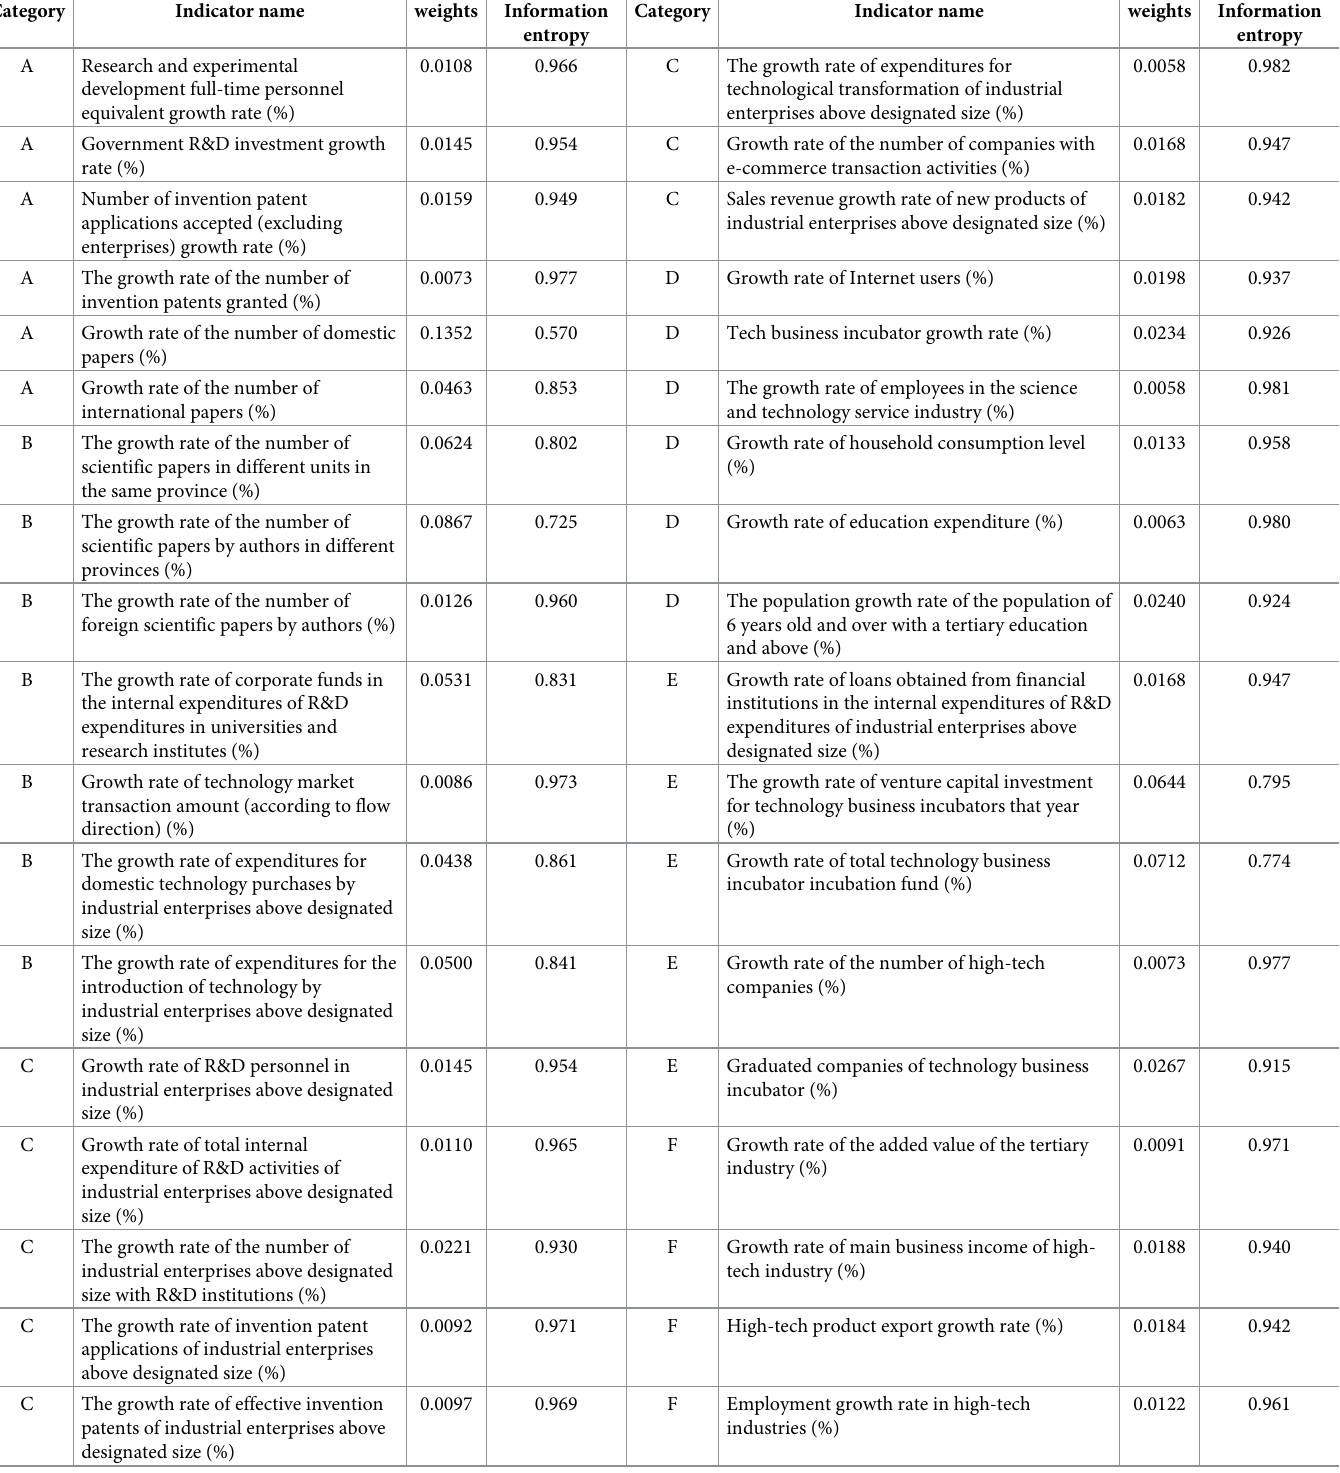
Table 2. Indicators and weights related to innovation